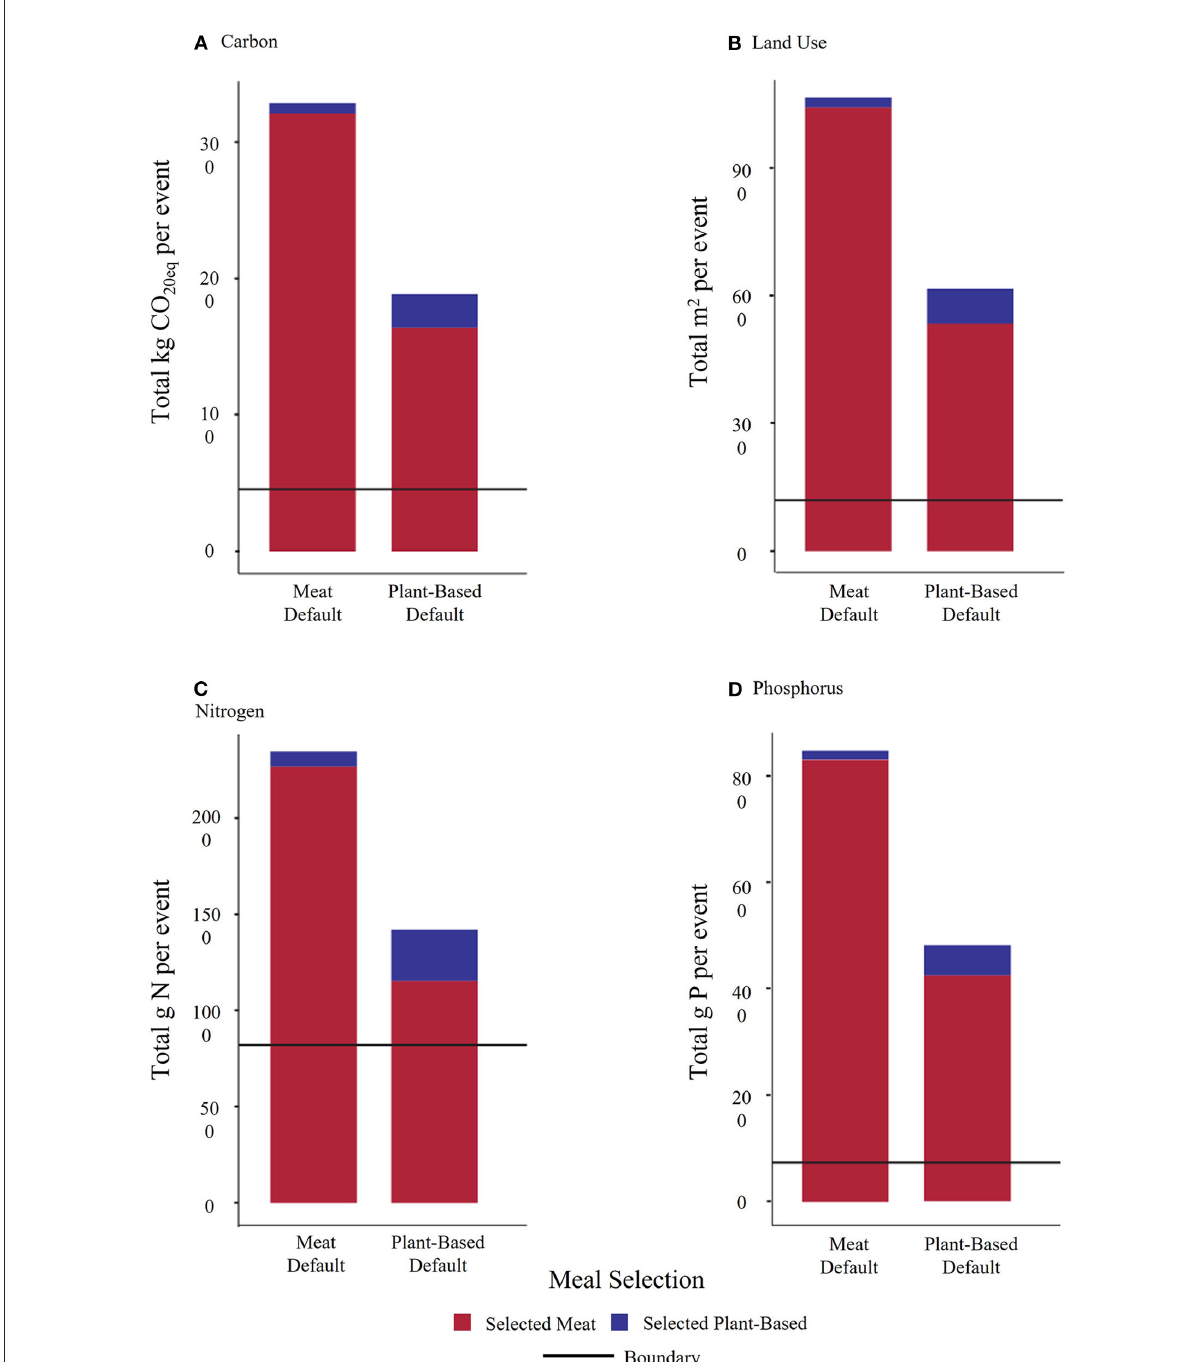
FIGURE3 (A–D) Plant-based and beef projected event calculations using the pooled RCT results. Colors represent breakdown of impacts from meat and plant-based meals. Black line represents EAT-Lancet’s planetary boundary for the measure (Willett et al., 2019).